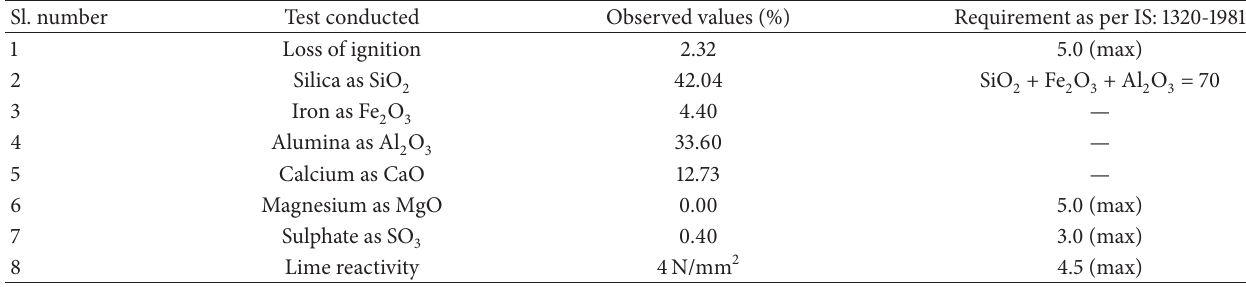
Table 3: Chemical properties of fly ash.